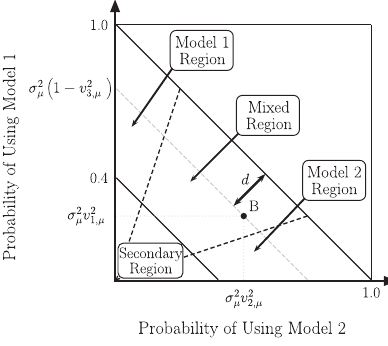
FIG. 1. Various regions of a model plot with two